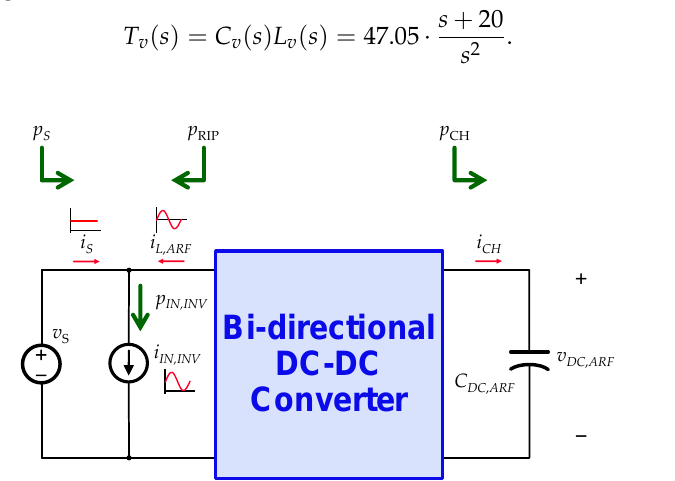
Figure 9. Small-signal equivalent circuit of the voltage loop.